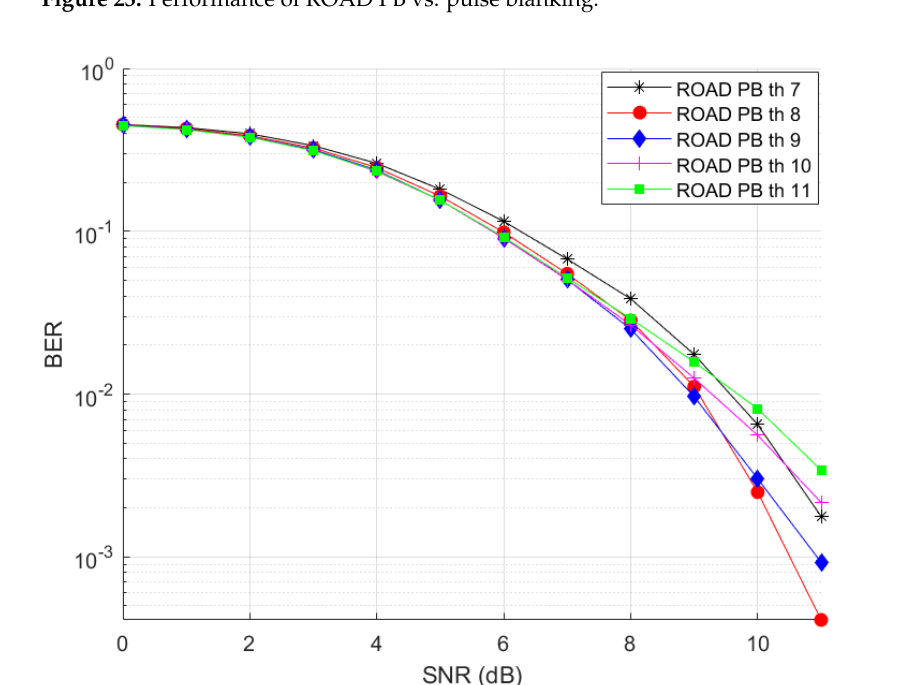
Figure 24. Variation of ROAD PB with different threshold